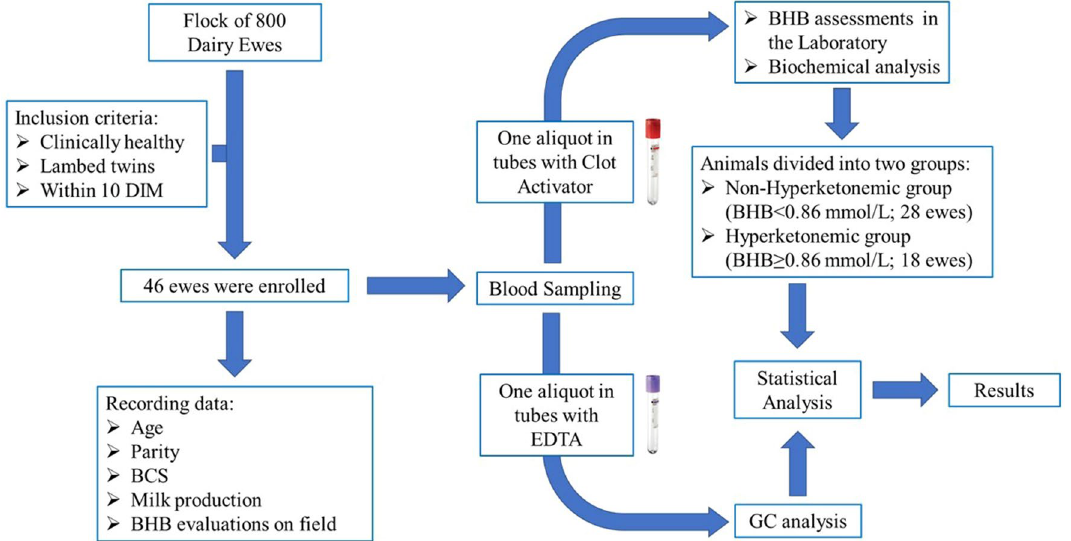
Figure 1. Flowchart of experimental